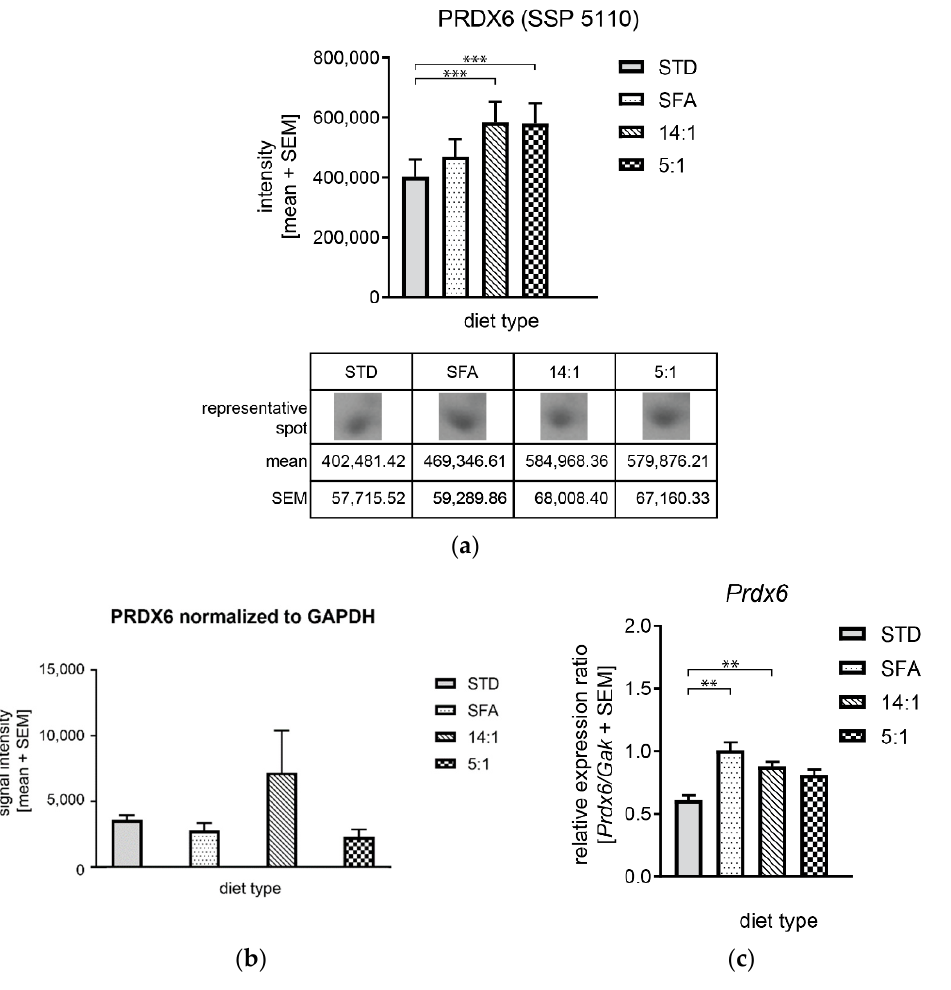
Figure 13. Alterations of PRDX6 expression in response to different high-fat diets. ( a ) Protein levels based on 2DE; ( b ) Western blotting analysis using anti-PRDX6 and anti-GAPDH antibodies and six mouse liver samples per group; signal intensities of PRDX6 were normalized to GAPDH signal intensities. Graphs presented a mean intensity with a standard error of the mean (SEM); ( c ) Prdx6 mRNA level normalized to Gak. **— p < 0.01; ***— p < 0.001.